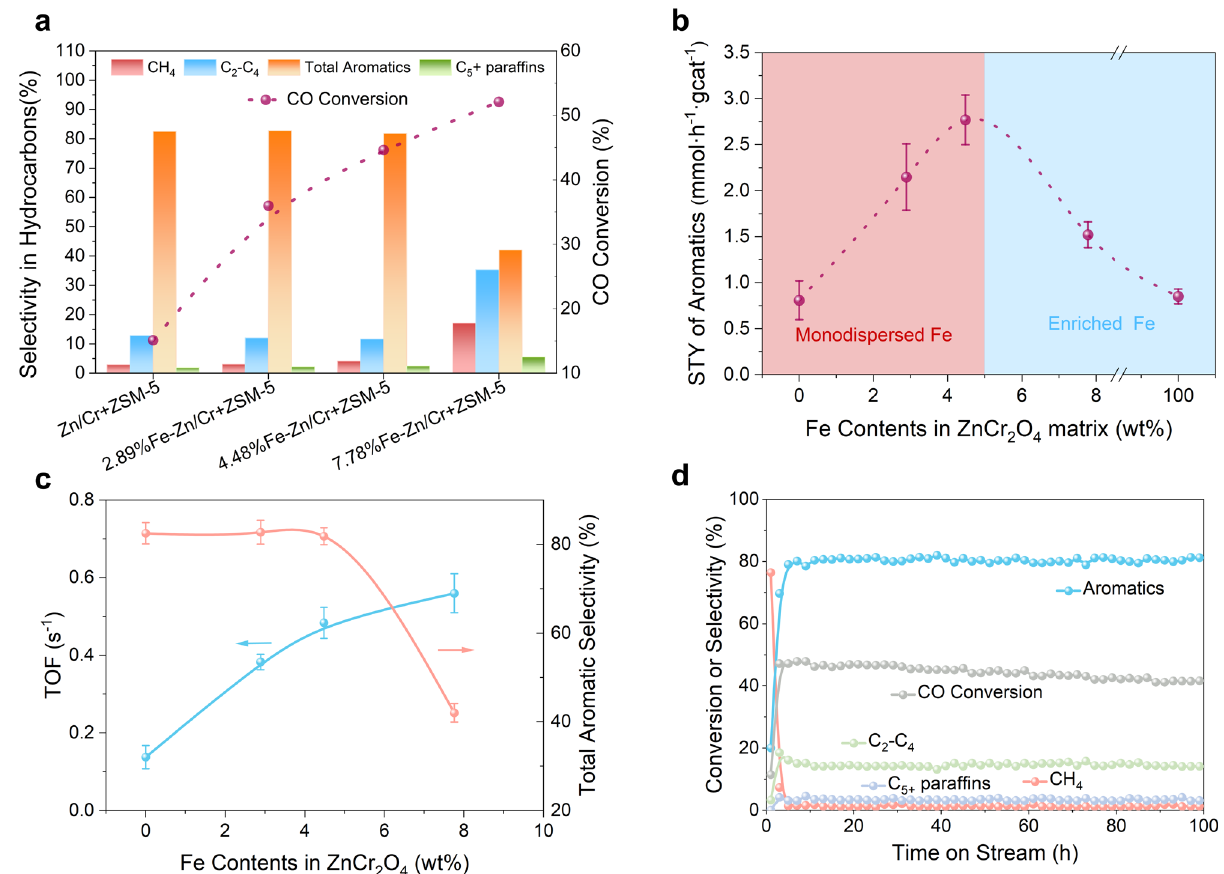
Fig. 2 | Catalyst evaluation of monodispersed and enriched Fe. a Catalyst eva- luation of pristine ZnCr 2 O 4 and different Fe-Zn/Cr with H-ZSM-5; reaction condi- tions: 350°C, 2.0MPa, space velocity=600mlh − 1 ·g cat − 1 , CO:H 2 =1:1. b The space- timeyield(STY)ofaromaticsfordifferentcatalysts. c TOFandaromaticselectivity